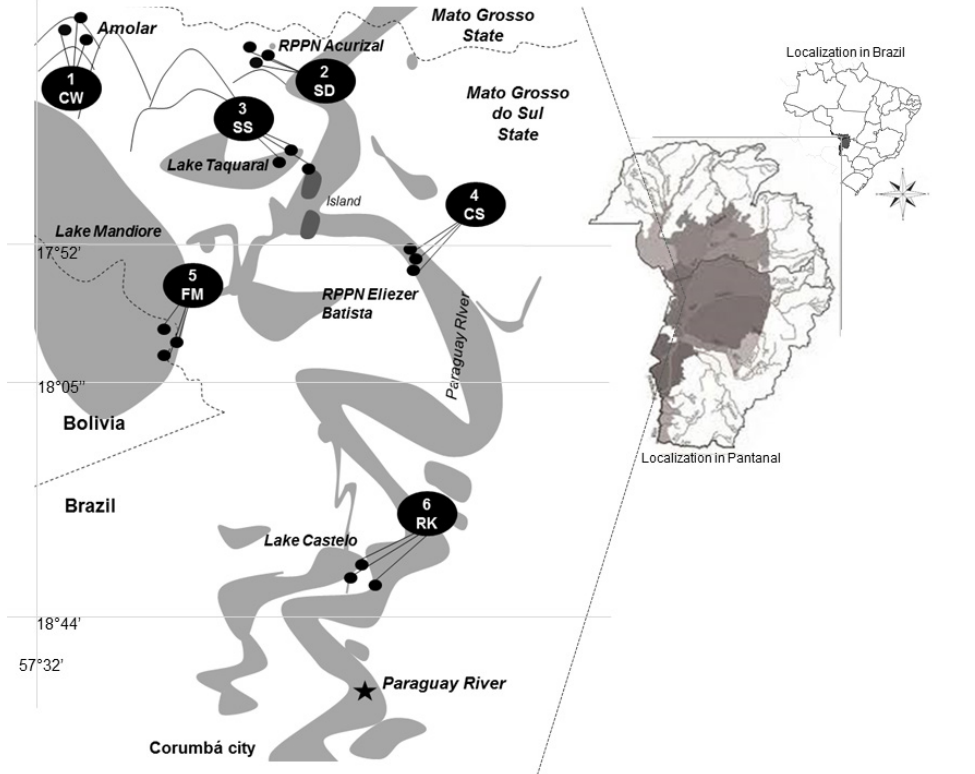
Figure 1 - Spatial distribution of the three collection sites in each studied area in the floodplain and residual relieves of the Upper Paraguay River, Pantanal wetland, Mato Grosso do Sul, Brazil, (map adapted from Silva and Abdon 1998). Area 1: CW (Cerrado woodland under impact of fire) - Serra do Amolar; Area 2: SD (seasonal semideciduous forest) - RPPN (private reserve) Acurizal; Area 3: SS (shrubby swamp with tree islets) - Lake Taquaral; Area 4: CS (Cerrado and semideciduous forest) - RPPN Eliezer Batista; Area 5: FM (floodable meadow) - Lake Mandioré; Area 6: RK (seasonal alluvial forest with rocky outcrop) - Lake